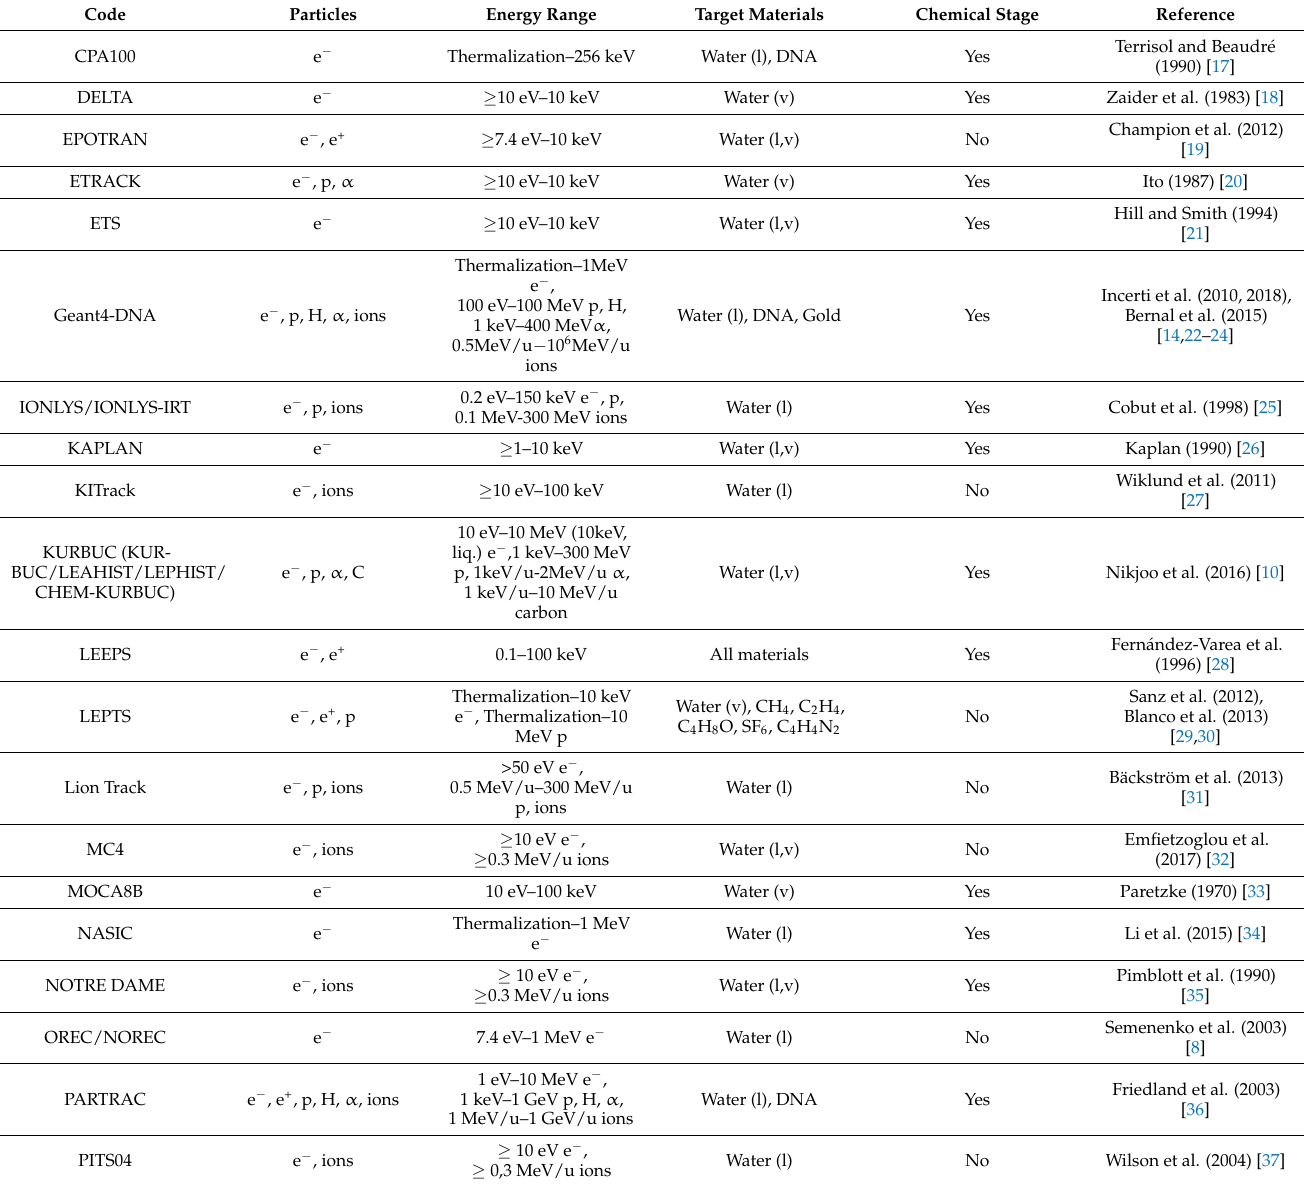
Table 1. MC track-structure codes that are used in various radiation effects studies in biological medium. Associated particles, energy ranges, and target media (e.g., whether vapor-v-or/and liquid- l-phase cross sections are used) are indicated. The degree of sophistication of the models differs for each code and it will not be further analyzed in this